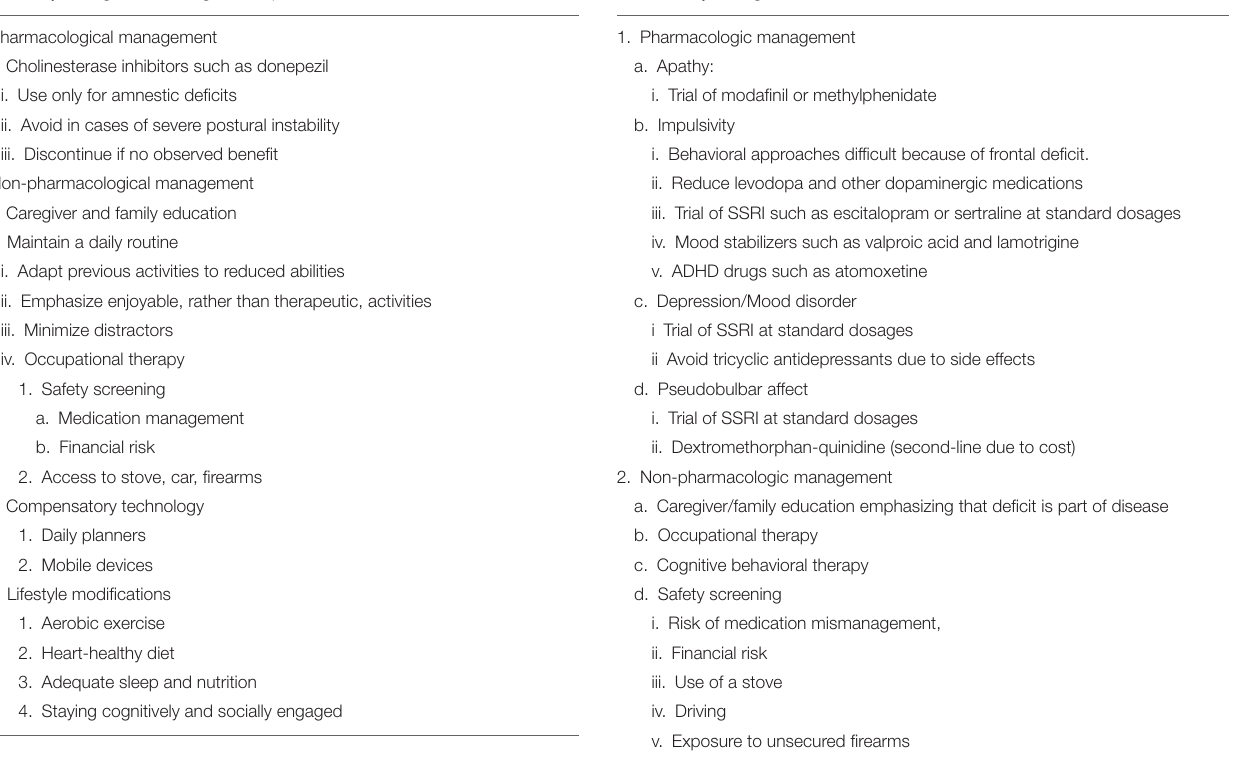
TABLE 10 | Management of cognitive impairment in PSP/CBS. TABLE 11 | Management of behavioral disturbances in